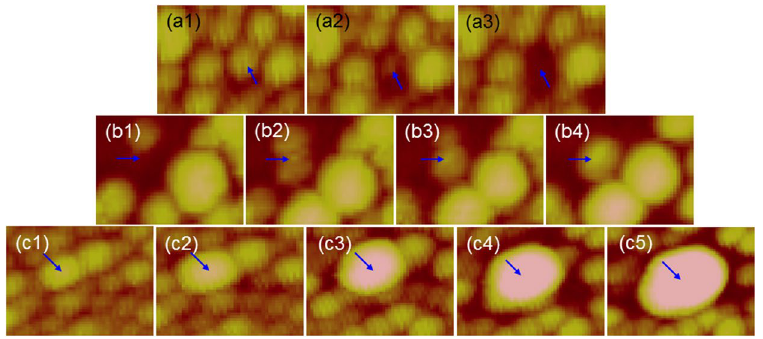
Figure 5. AFM images (100 nm × 75 nm) showing Ag NP reorganization behaviors of an Ag NP sample illuminated by the 395-nm LED in air. ( a1–a3 ) AFM images of an area under illuminations for 0.5, 1, and 1.5 hours, respectively, to show the disappearance of an NP. ( b1–b4 ) AFM images of another area under illuminations for 10, 11, 12, and 14 hours, respectively, to show the formation of a new NP. ( c1–c5 ) AFM images of the other area under illuminations for 0.5, 1, 2, 3, and 4 hours, respectively, to show the merge of a few Ag NPs into a larger